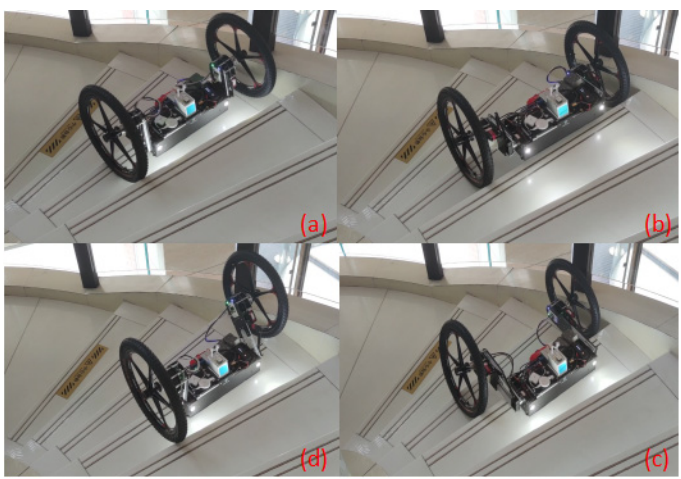
Figure 19. Spiral stair climbing test of robot: ( a ) the robot approaches and automatically aligns the rotating stairs; ( b ) the robot’s cantilevers lifting frame; ( c ) the robot extends its cantilevers and puts its frame on the stairs; ( d ) the robot wheels are successively lifted to the steps of the frame, and the robot enters the gait of “approaching” again.